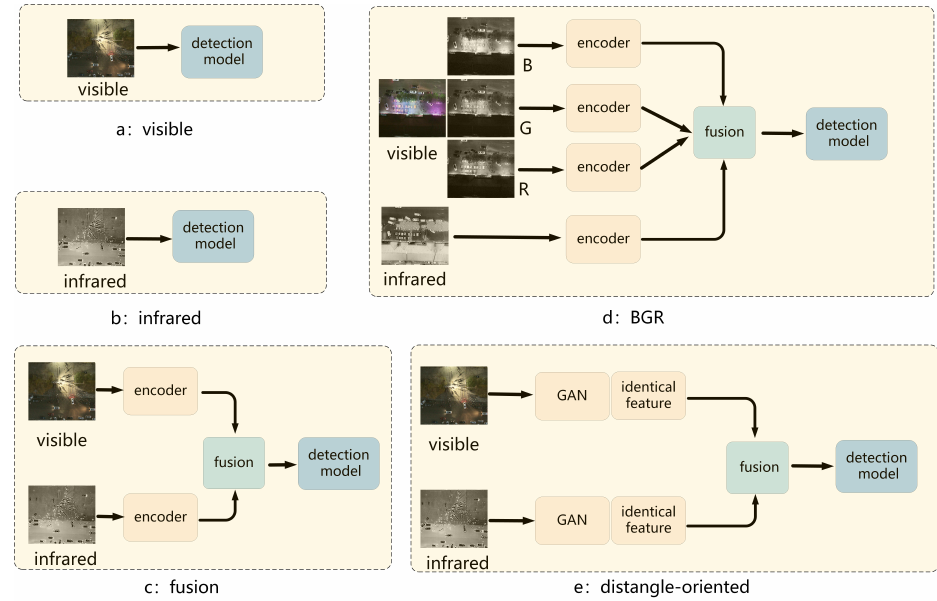
Figure 4. The structures of six comparisons.